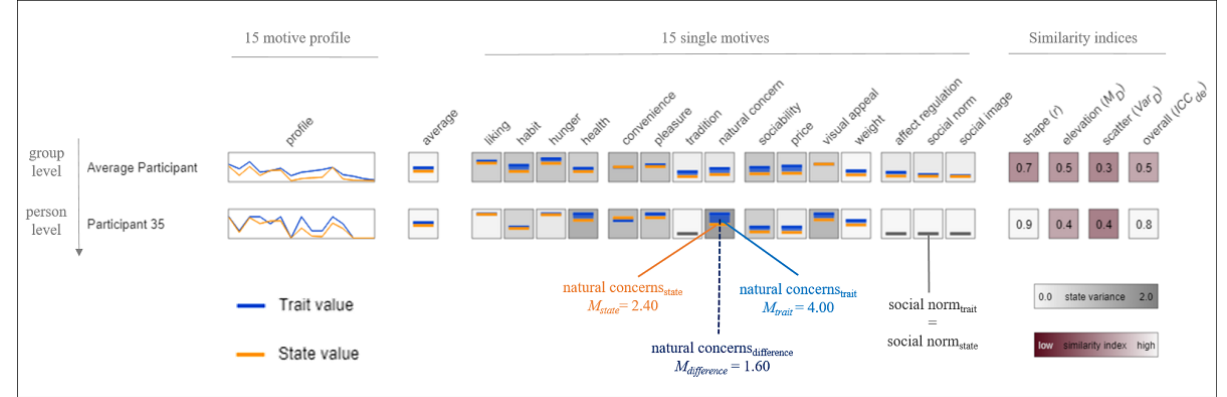
Figure 2. Illustration of the visualized person x motive data matrix and similarity indices for the 15 trait and state eating motive profiles. The first line displays data for the average participant (between-person level). The second line displays data for a single participant (No. 35) (within-person level). D=Difference score (trait value—state value).